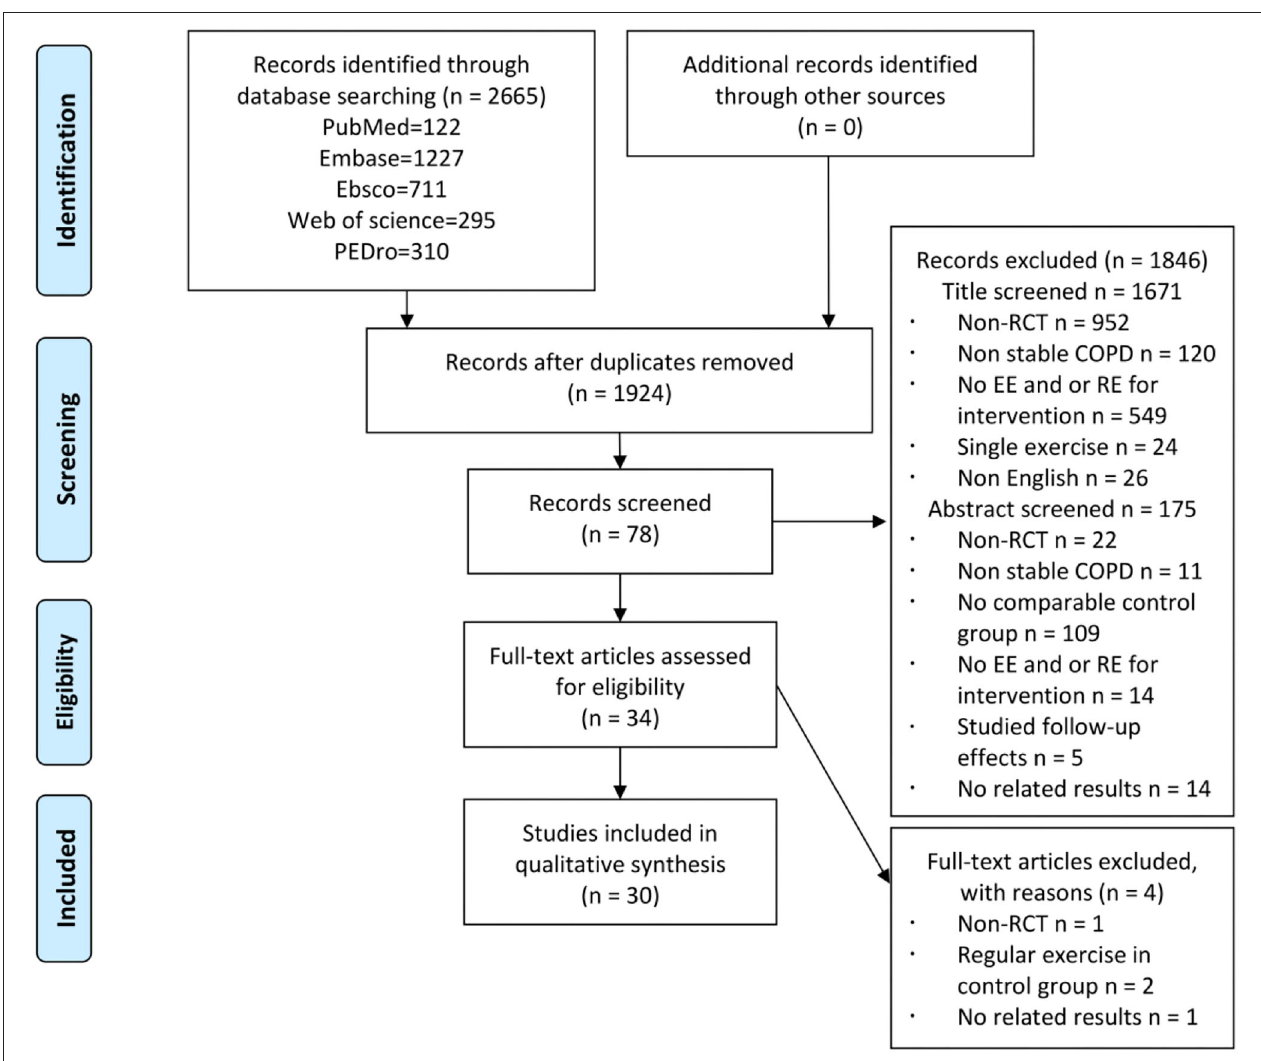
FIGURE 1 | Study flow diagram. COPD, chronic obstructive pulmonary disease; EE, endurance exercise; RCT, randomized controlled trial; RE, resistance